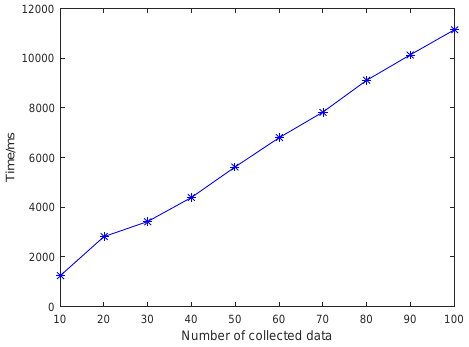
Figure 2. Computational costs on the vehicle